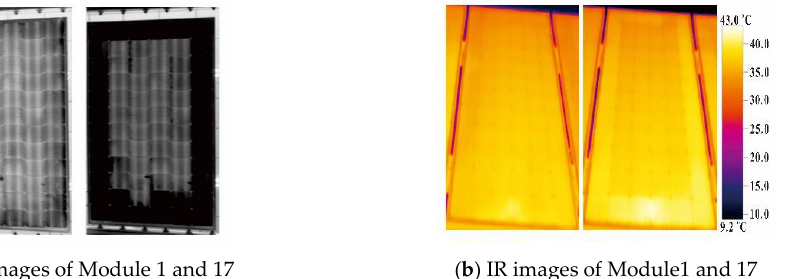
Figure 10. The electroluminescence images and thermography images of monocrystalline silicon solar modules from the same PID-affected module string. The left in Figure 10a is electroluminescence image for module 1, the right in Figure 10a is electroluminescence image for module 17. The left in Figure 10b is thermography image for module 1, the right in Figure 10b is thermography image for module 17. The solar cells near to the aluminium frame exhibit higher temperatures than the middle solar cells in module 17. Reprint from [33]. Copyright 2017, Elsevier.